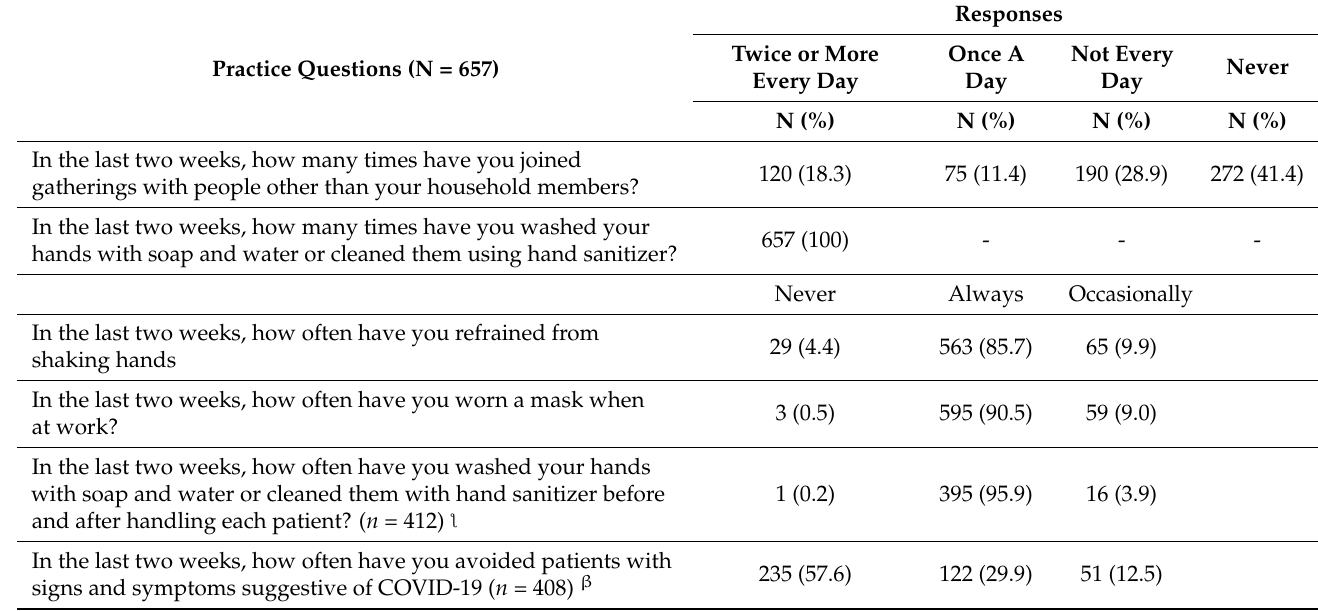
Table 4. Descriptive summary of COVID-19 practices among HCWs in Uganda.